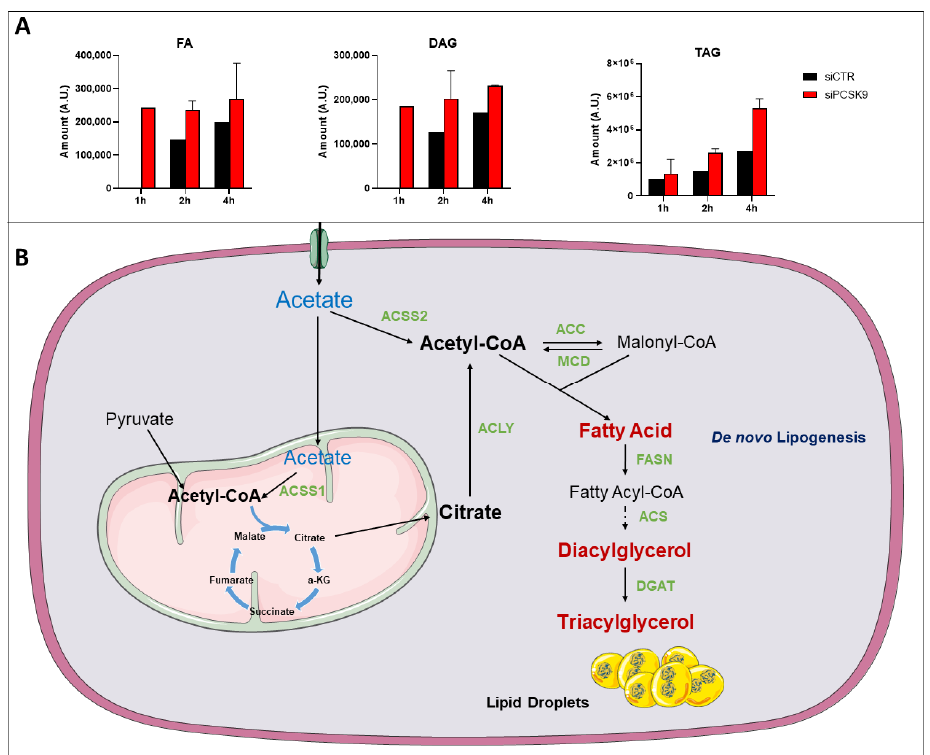
Figure 5. PCSK9 deficiency leads to intracellular accumulation of lipid droplets. ( A ) Validation of depletion of PCSK9 by shRNA silencing. Cell extracts were prepared after transduction with control shRNA (shCTR) or targeting PCSK9 (shPCSK9) of Huh6 or Huh7 or HepG2 cells. Different MOIs (multiplicity of infection) were tested: 1, 3, 5 and 10; the latter was picked for further experiments. A total of 40 µg of cell proteins was loaded per lane on an SDS-PAGE. After electrophoresis and transfer, the membrane was analyzed by Western blot using anti-PCSK9 antibodies and GAPDH antibodies for comparison of loading. The two bands observed for PCSK9 correspond to the pro- PCSK9 (74 kDa) and cleaved PCSK9 (60 kDa). ( B ) Confocal microscopy observation of HepG2 cells performed 48 and 72 h after transfection with PCSK9 siRNA (si1) and siCTR. Mitochondria were labeled with C/YFP using a specific lentivirus targeting system (MitoC/YFP). Phalloidin (red) and DAPI (blue) were used for microfilament and nuclear DNA staining, respectively. Arrows indicate bright mitochondria network observed more frequently when PCSK9 is silenced. ( C , D ) Transmis- sion electron microscopy (TEM) photomicrographs of liver cancer cell lines transduced with specific PCSK9 shRNA (shPCSK9) or control shRNA (shCTR). Dark and dense particles seen at lower and higher magnification are lipid droplets. Stars (*) indicate PDM. Abbreviations: LD: lipid droplet; PDM: peridroplet mitochondrion. Supplementary Materials: original-images of western blot fig- ures.